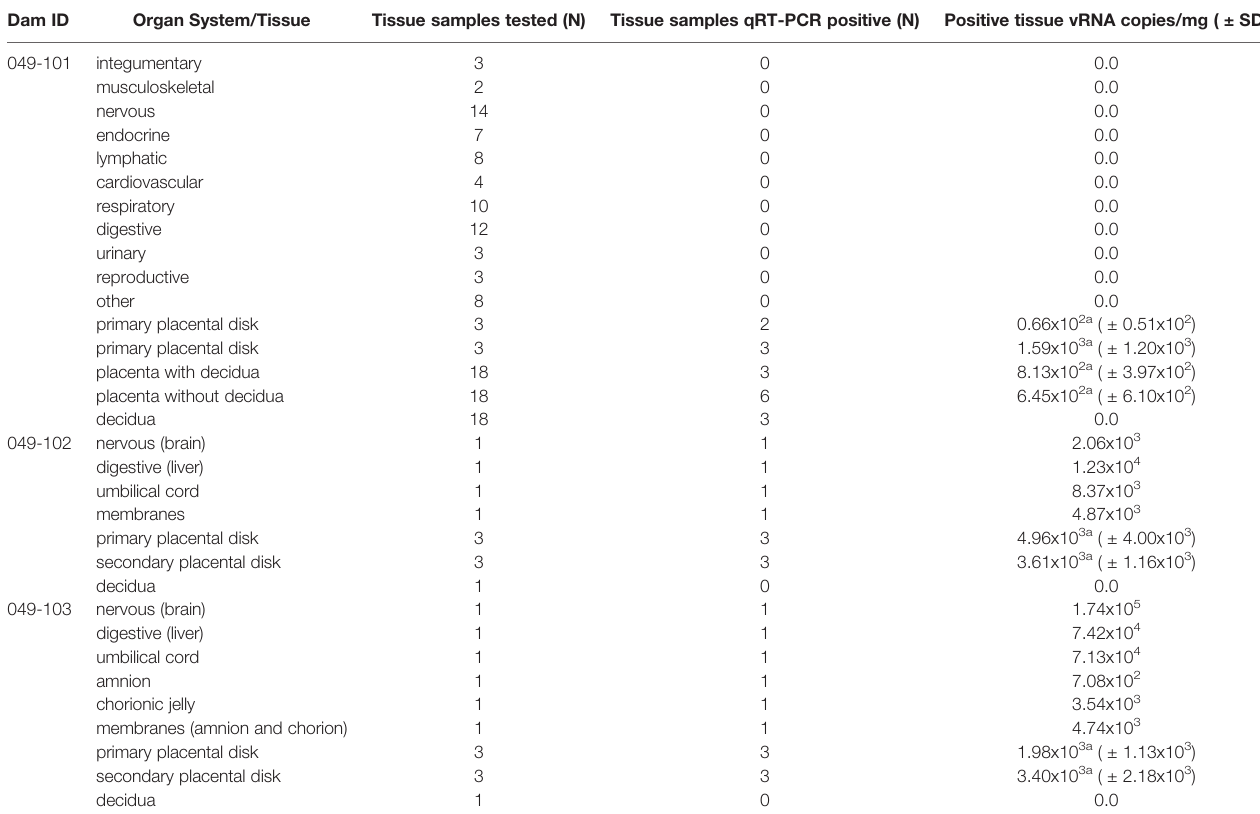
TABLE 2 | Fetal and maternal-fetal interface tissues collected at